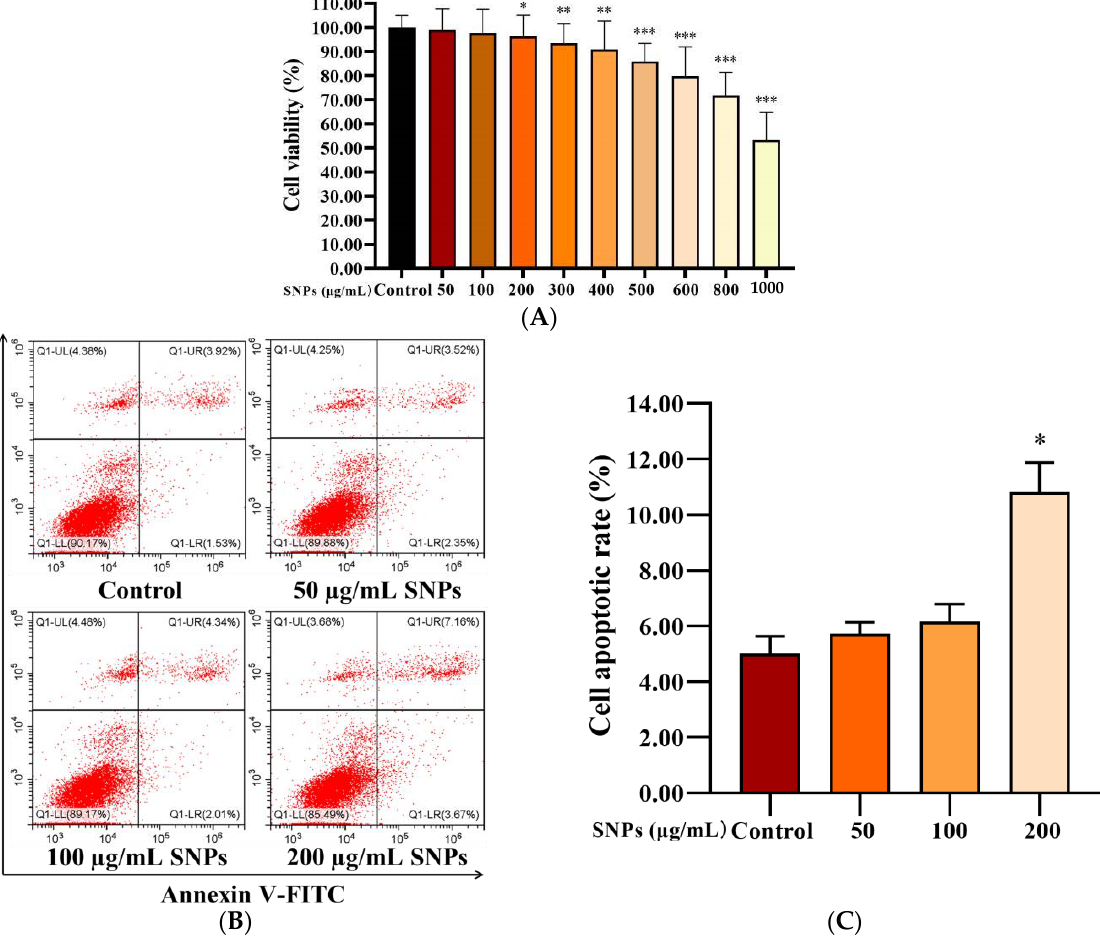
Figure 3. Effect of SNPs on cell viability in PLCs. ( A ) CCK-8 assay of the effect of SNPs on cell viability in PLCs. Cells were exposed to 0, 50, 100, 200, 300, 400, 500, 600, 800, and 1000 µg/mL SNPs for 24 h. ( B ) Flow cytometry analysis of the effect of SNPs on cell apoptosis in PLCs. After exposure to 0, 50, 100, and 200 µg/mL SNPs for 24 h, PLCs were collected for annexin V-FITC/PI staining. The UL quadrant indicates cell death caused by mechanical damage or necrotic cells, the UR quadrant indicates late apoptotic cells, the LL quadrant indicates normal cells, and the LR quadrant indicates early apoptotic cells. ( C ) The quantification of cell apoptosis in B is shown in the bar graphs. Data are presented as the mean ± SEM of three independent experiments. * Statistically different from the control (* p < 0.05, ** p < 0.01, and *** p < 0.001).